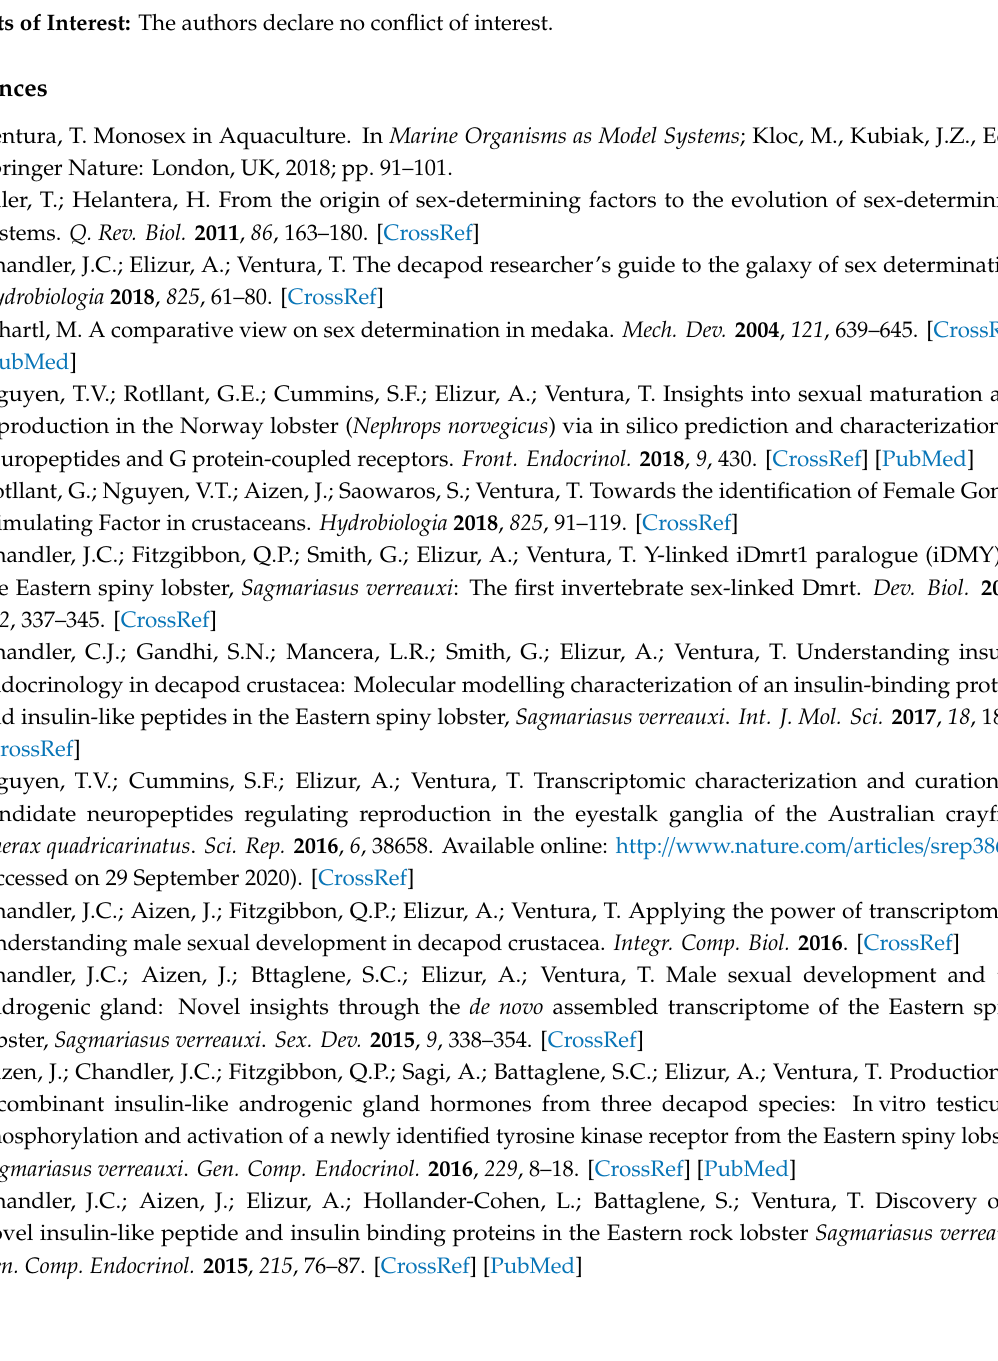
Table S1: Panulirus ornatus sexual development factors sequences and BlastP results summary; File S1: Panulirus ornatus Dmrts